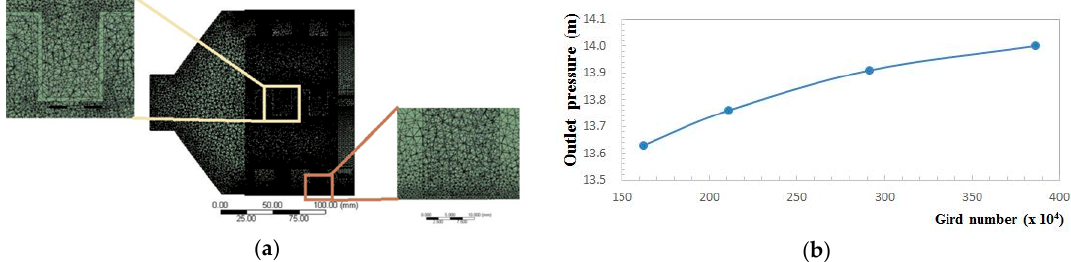
Figure 4. Grid map analysis of pump. ( a ) Local grid map of pump closed to the gaps; ( b ) mesh sensitivity curve.